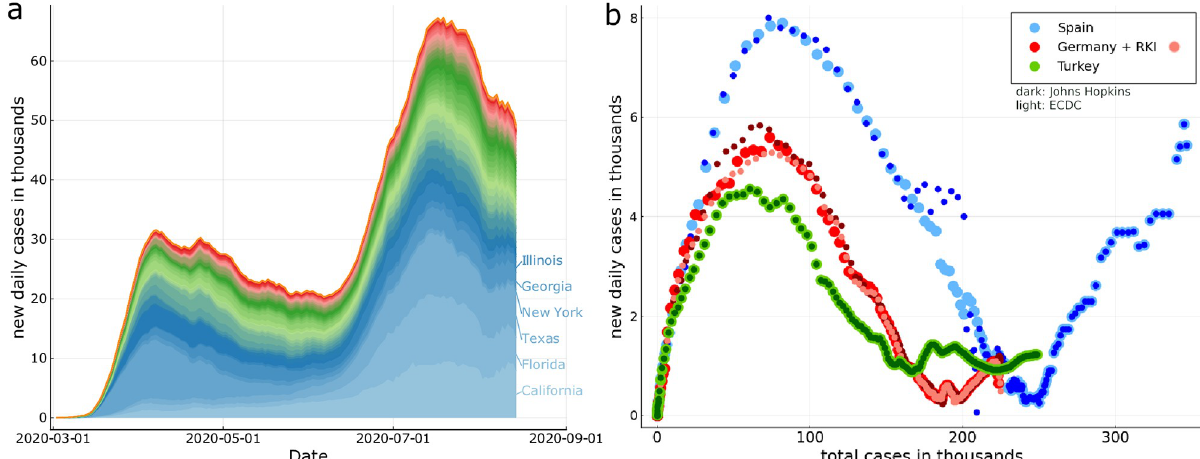
Fig 2. COVID-19 outbreak examples. Left : The timeline of the daily new infections for all US states, where the state with the biggest cumulative case count is set at the bottom, and the one with the lowest at the top. The curves are in part strongly asymmetric with respect to the time it takes for the outbreak to build up and to recede. A second, prominent peak is present. Right : Daily counts Δ X are plotted as a function of total counts X , which defines the XI-representation. For Spain, Germany and Turkey a comparison of ECDC (European Center of Disease Control), the Johns Hopkins, and the RKI (Robert Koch Institute, Germany) data. Seven-day moving averages have been used. Note the substantial scattering of the later-stage COVID- 19 data for Spain, which is due to changes of official counting protocols. For the data sources see Data sources section.